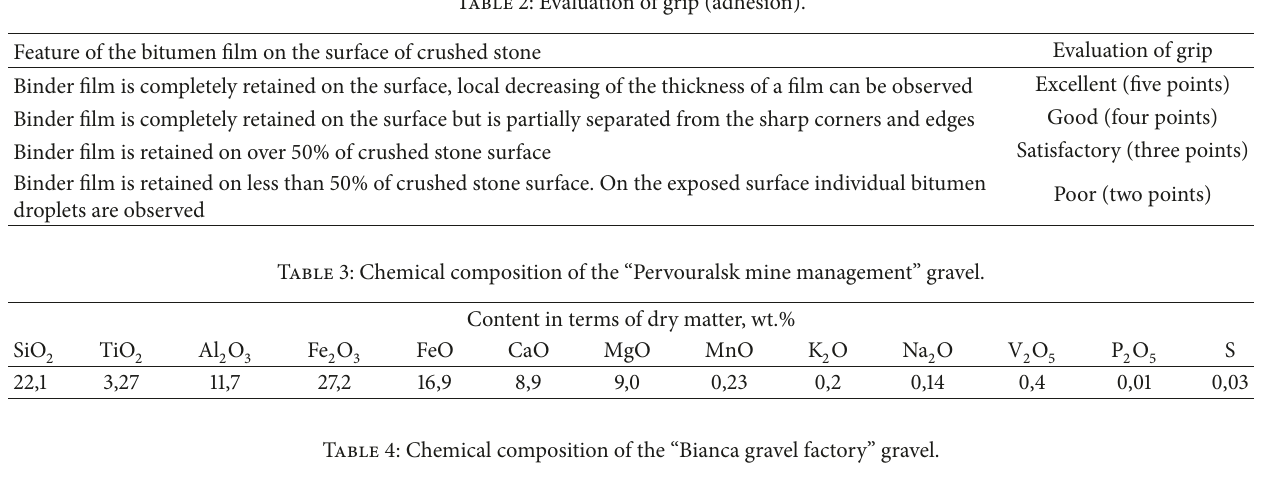
Table 2: Evaluation of grip (adhesion).